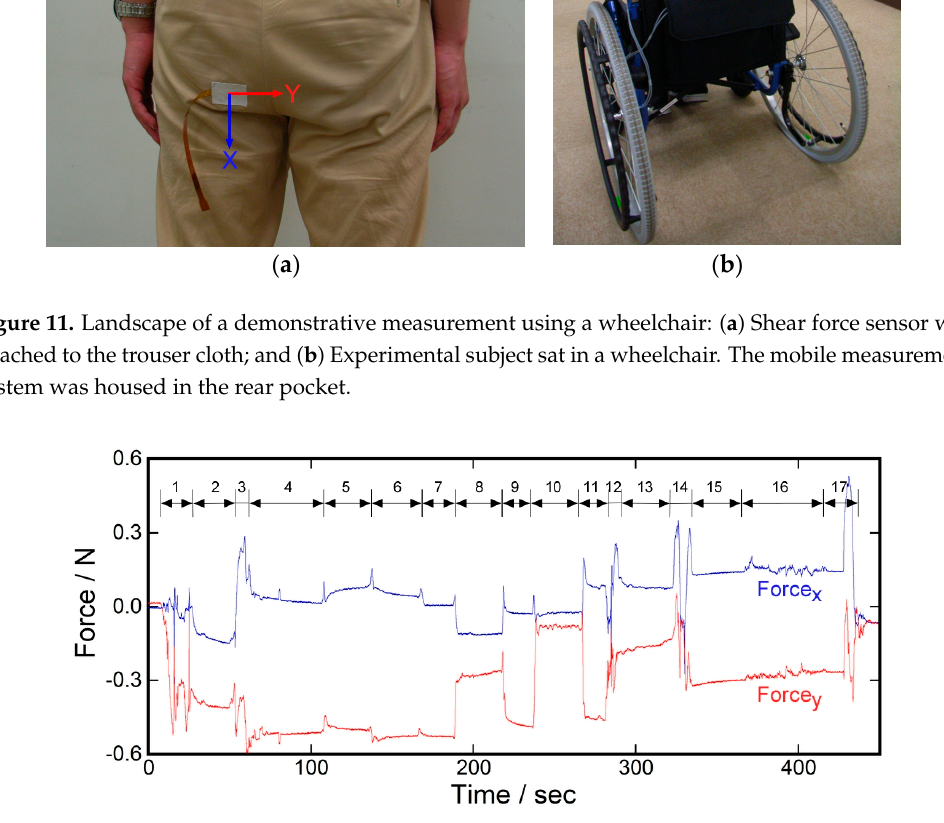
Figure 12. Time course of the measurement result of the demonstrative experiment using the shear force sensor. The test subject changed posture as indicated by the numbers: (1) Sitting down on the wheelchair; (2) Resting; (3) Putting feet on the footrest; (4) Resting; (5) Slouching; (6) Bending backward; (7) Resting; (8) Tilting the body to the left; (9) Resting; (10) Tilting the body to the right; (11) Resting; (12) Slightly detaching the buttocks from the cushion sheet and sliding forward; (13) Bending Backward; (14) Slightly detaching the buttocks from the cushion sheet and sliding to the original position; (15) Resting; (16) Other person pushing the wheelchair randomly (the test subject did nothing); and (17) Standing up.